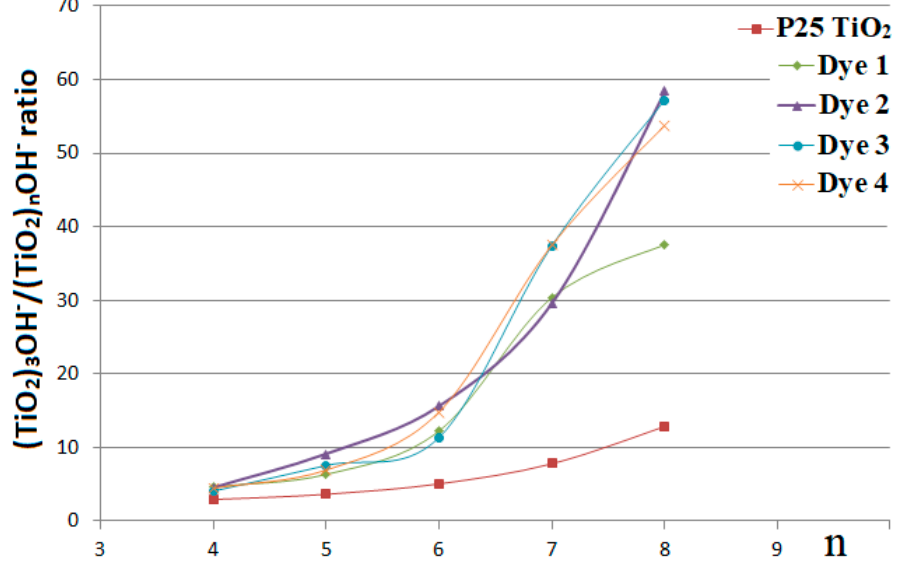
Figure 4. The breakdown plots of the (TiO 2 ) 3 OH − /(TiO 2 ) n OH − ratio against the n number obtained for the unmodified P25 TiO 2 and dye-modified samples.